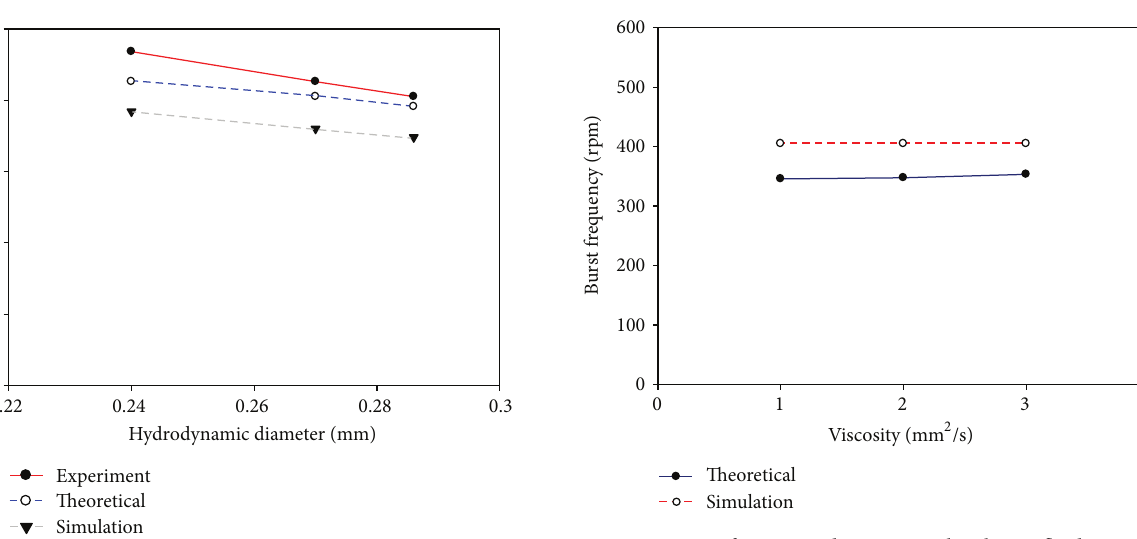
Figure 13: Burst frequency decreases with a larger hydrodynamic diameter when the titrant is mercurochrome.